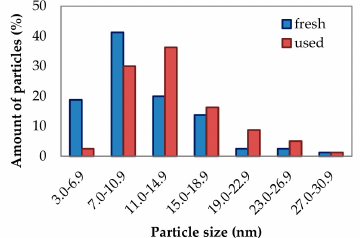
Figure 8. Particle size distribution in fresh and used K(II) / 600 / 4